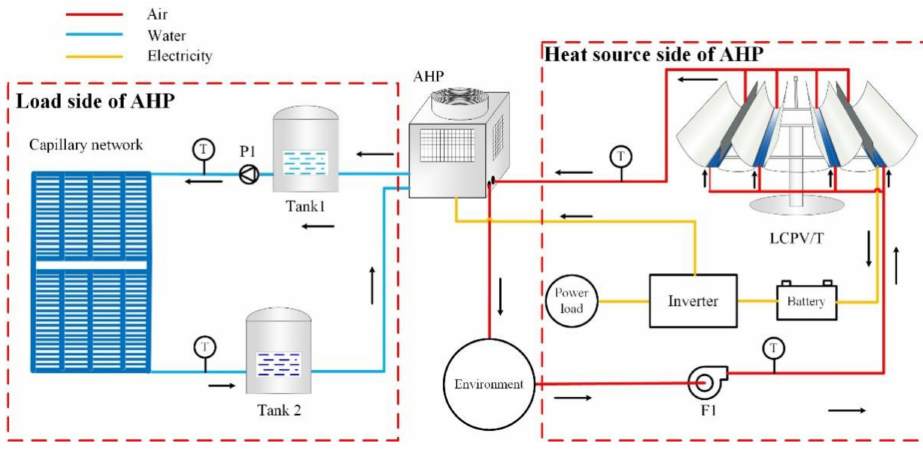
Figure 3. Schematic diagram of the LCPV/T coupled with AHP